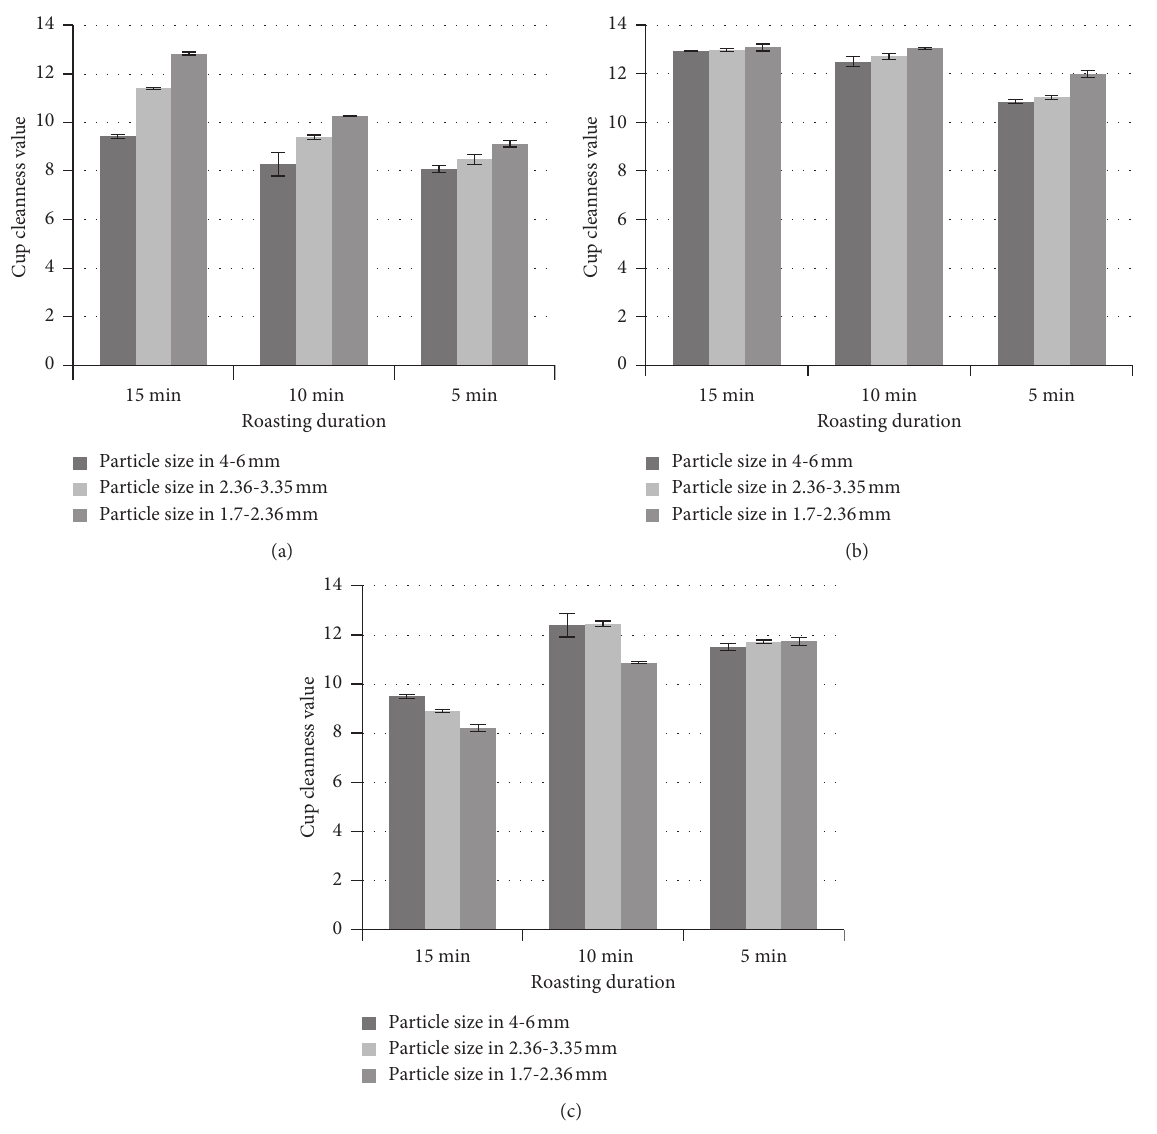
Figure 4: Effect of coffee bean particle size, roasting temperature, and roasting time on the cup cleanness value of the coffee beverage. (a) Roasting temperature at 200 ° C. (b) Roasting temperature at 230 ° C. (c) Roasting temperature at 260 °